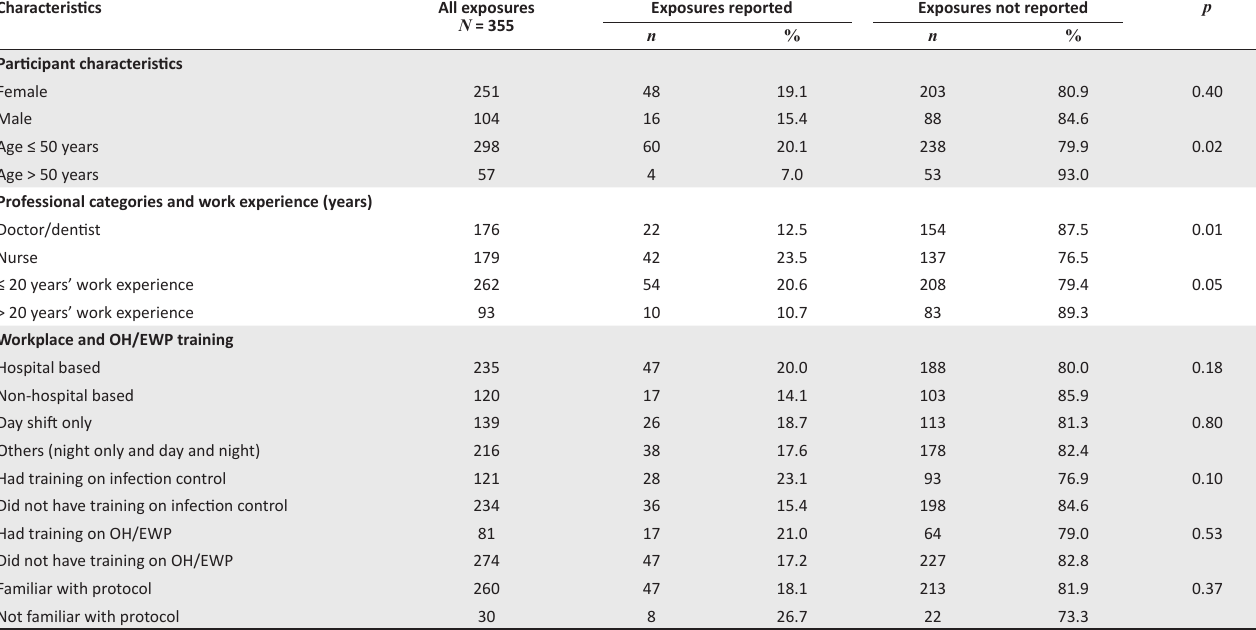
TABLE 6. Association between participants’ descriptors and the number of blood and body fluids reported.